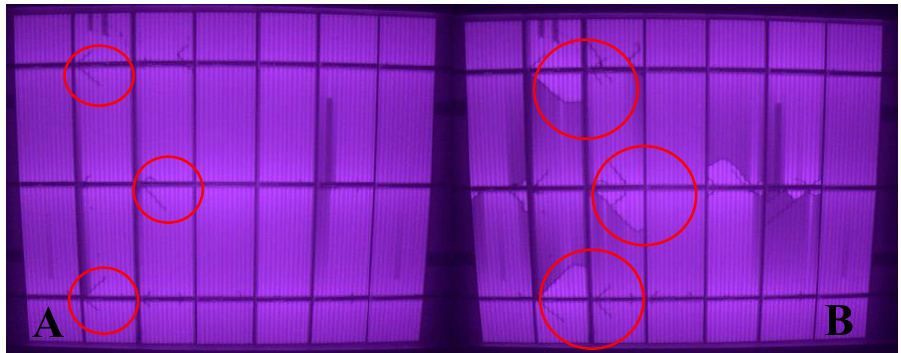
Figure 6. EL test of receiver 1: ( A ) Baseline (ambient temperature); ( B ) After the round at 130 °C.